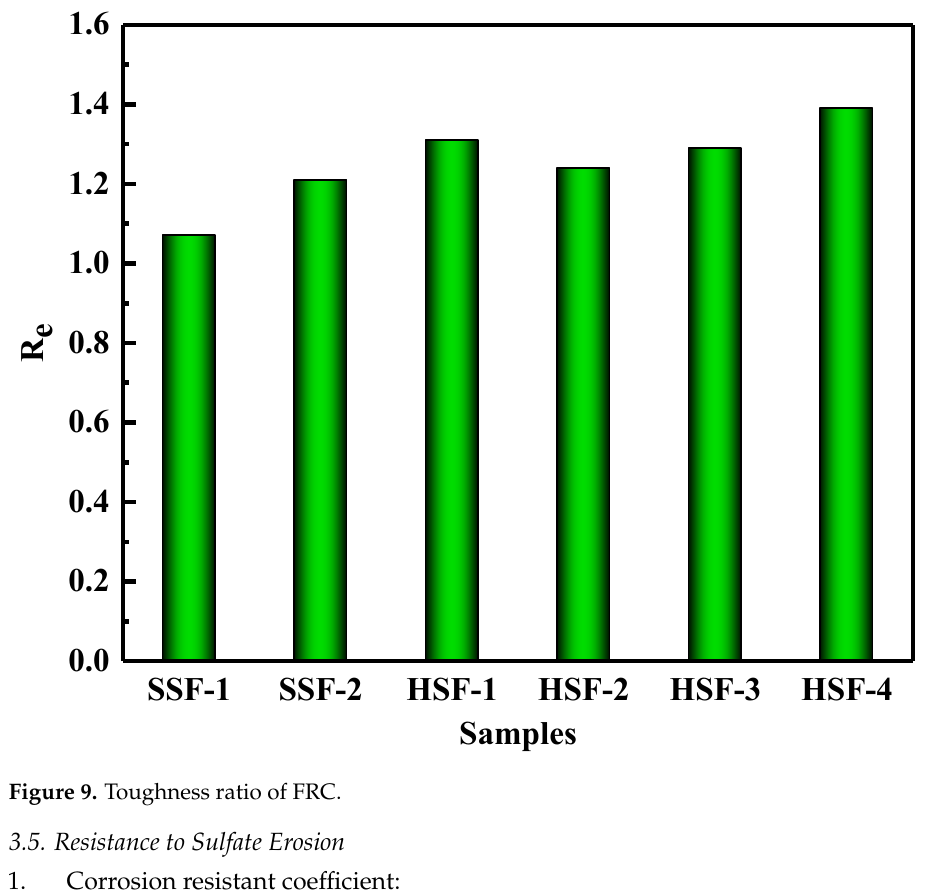
Figure 9. Toughness ratio of FRC.